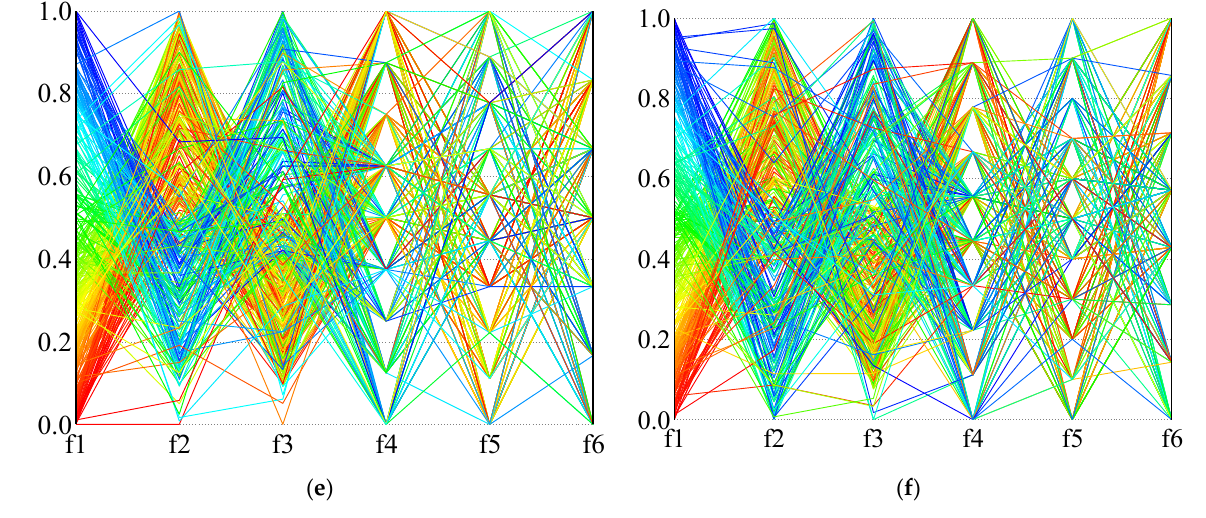
Figure 14. Parallel coordinates plot of instance 1A: ( a ) NSGA-III-L; ( b ) NSGA-III-NL; ( c ) NSGA-II-L; ( d ) NSGA-II-NL; ( e ) RWGA-L; ( f ) RWGA-NL.